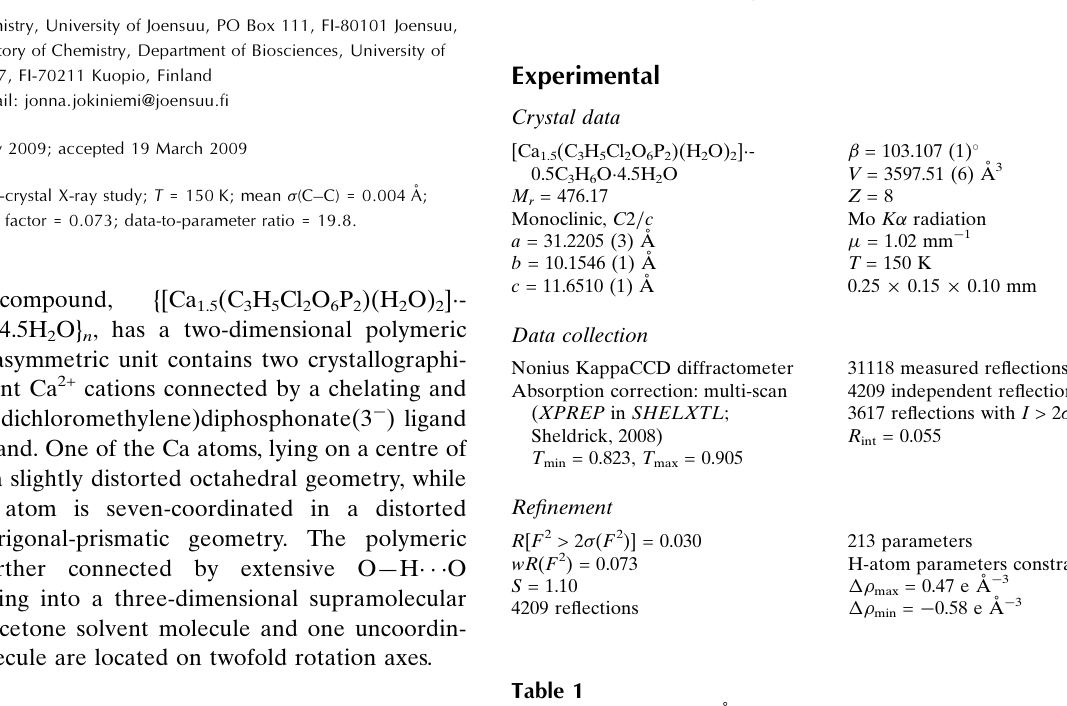
Selected bond lengths (A˚ ).